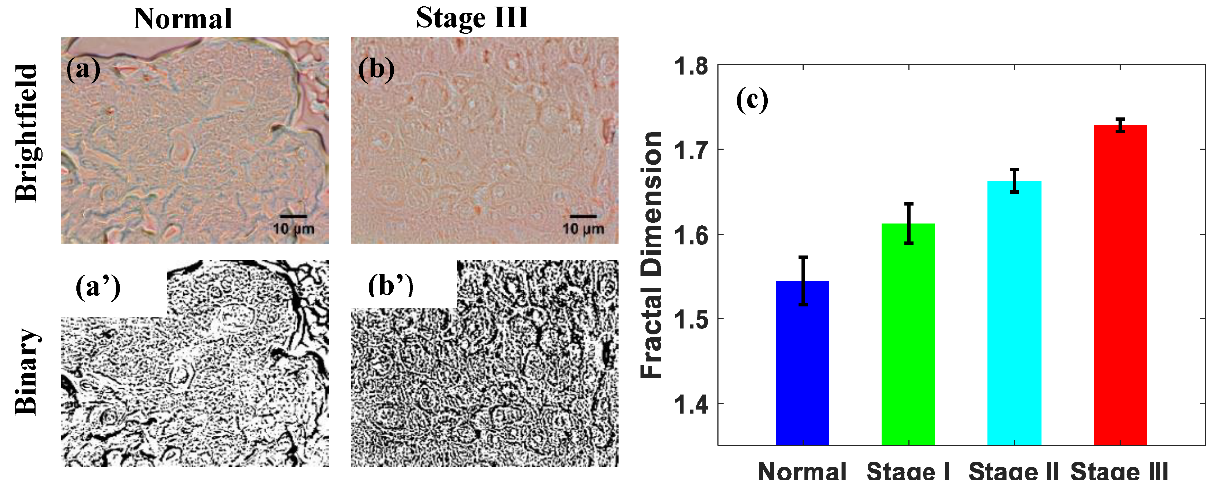
Figure 3. Breast cancer: ( a , b ) are the brightfield images of the normal and stage III Breast TMA. ( a’ , b’ ) are the corresponding binary images. ( c ) is the bar graph of the average fractal dimension of the Breast cancer tissue microarrays (TMA) samples (n = 24, 3–5 subjects per stage). The results show the fractal dimension of cancer stage I increases by 4%, stage II by 7%, and stage III by 12% with respect to the normal ( p -values < 0.05).